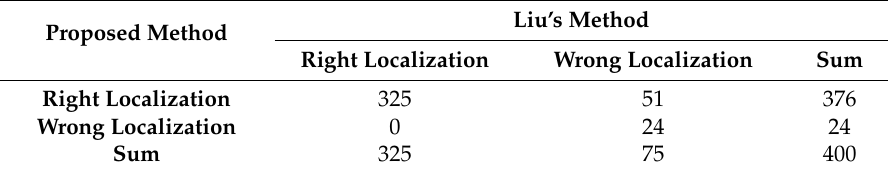
Table 1. The localization accuracy of Liu’s method and the proposed method.